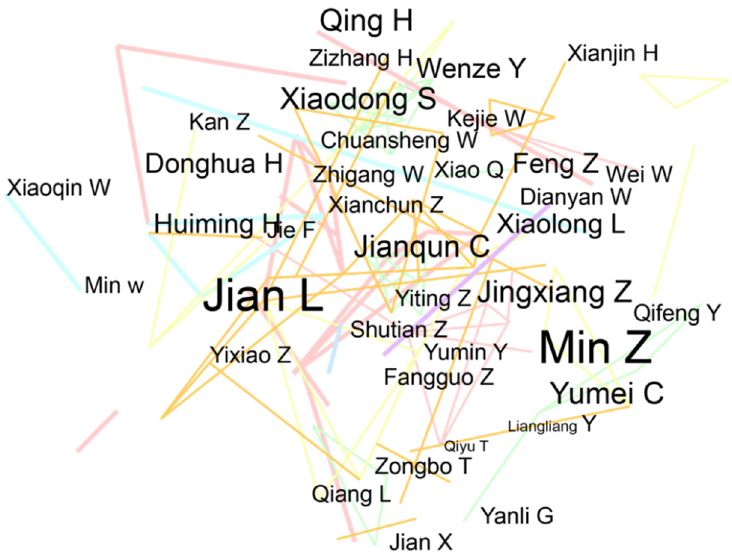
Figure 12. Visualization of the authors’ network (CNKI